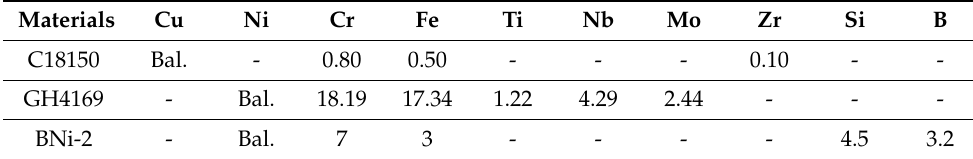
Table 1. Chemical compositions (wt. %) of parent and filler materials.